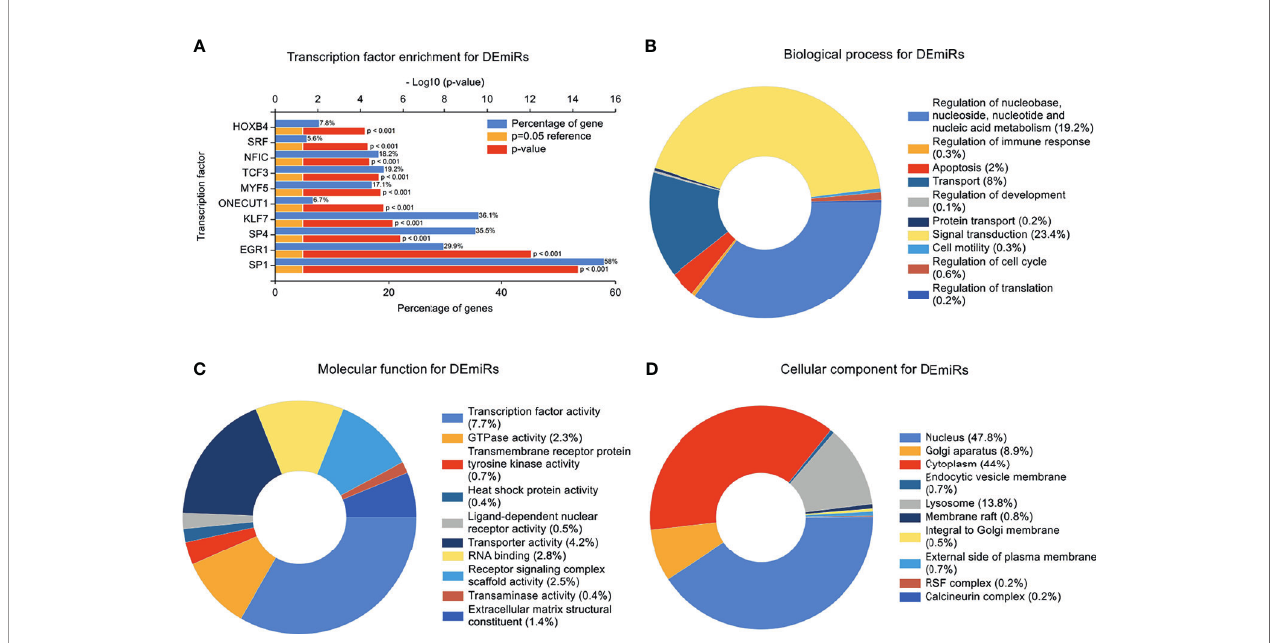
FIGURE 4 | Transcription Factor Enrichment and GO Enrichment Analysis. (A) Transcription factors (TF) of the differentially expressed miRNAs (DEmiRs) from FunRich. Blue bars, orange bars, and red bars represent percentage of predicted genes, reference of P=0.05, and p value, respectively. (B) mRNAs involved in biological process terms for DEmiRs. (C) mRNAs involved in molecular function terms for DEmiRs. (D) mRNAs involved in cellular component terms for DEmiRs.